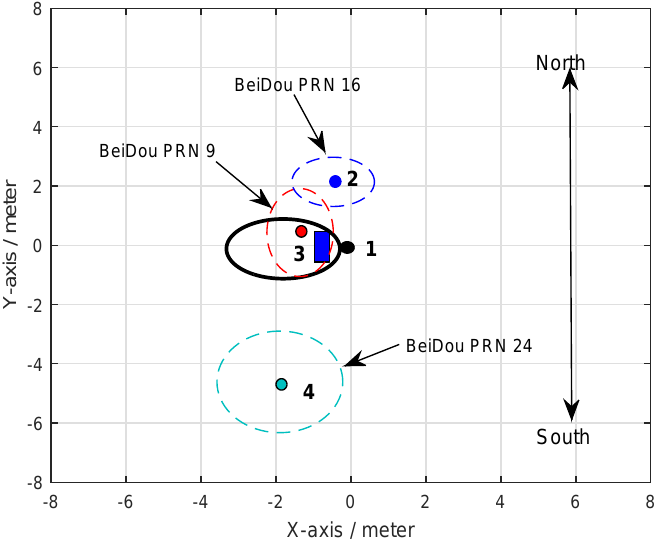
Figure 10. Reflection points of each BeiDou satellite on ( x , y ) planes in the first